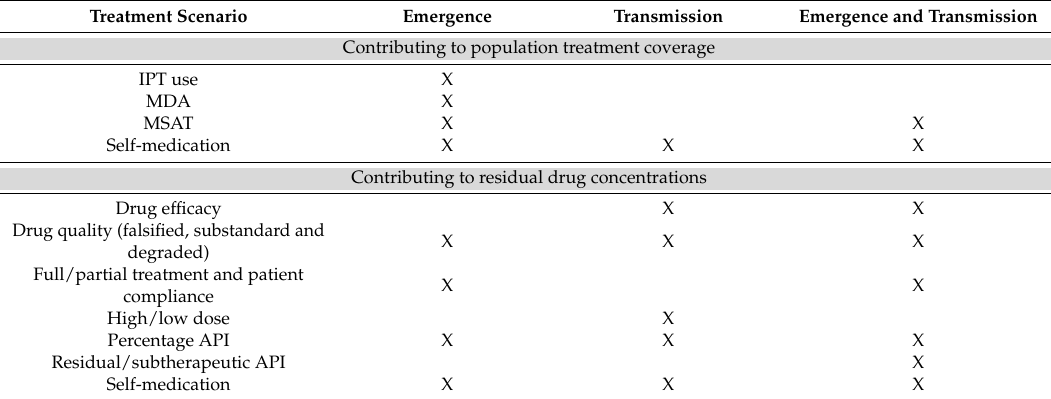
Table 2. Areas of future mathematical modeling research that contribute to the main drivers of the emergence and transmission of resistance identified in the scoping review, where gaps are indicated by ‘X’. Treatment Scenario Emergence Transmission Emergence and